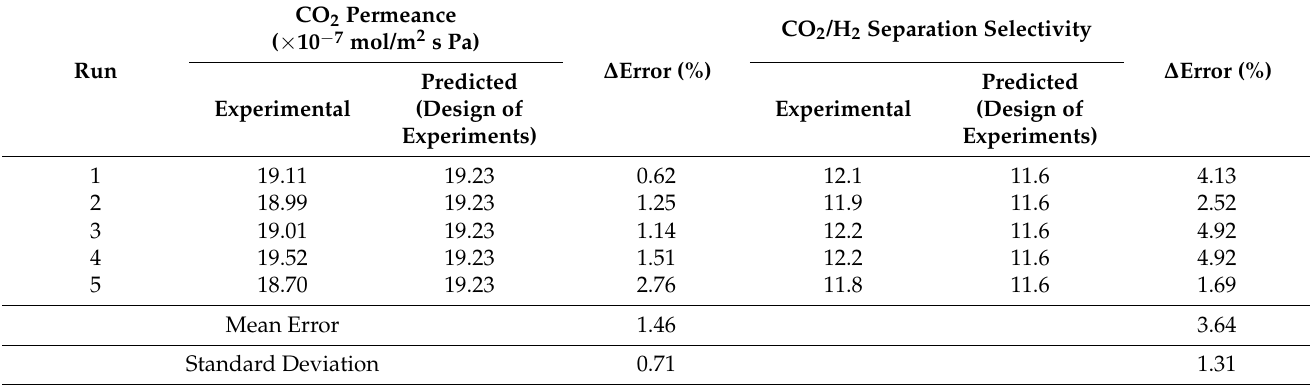
Table 7. The results of the additional CO 2 /H 2 separation experiments conducted at optimum operating condition generated by Design of Experiments.